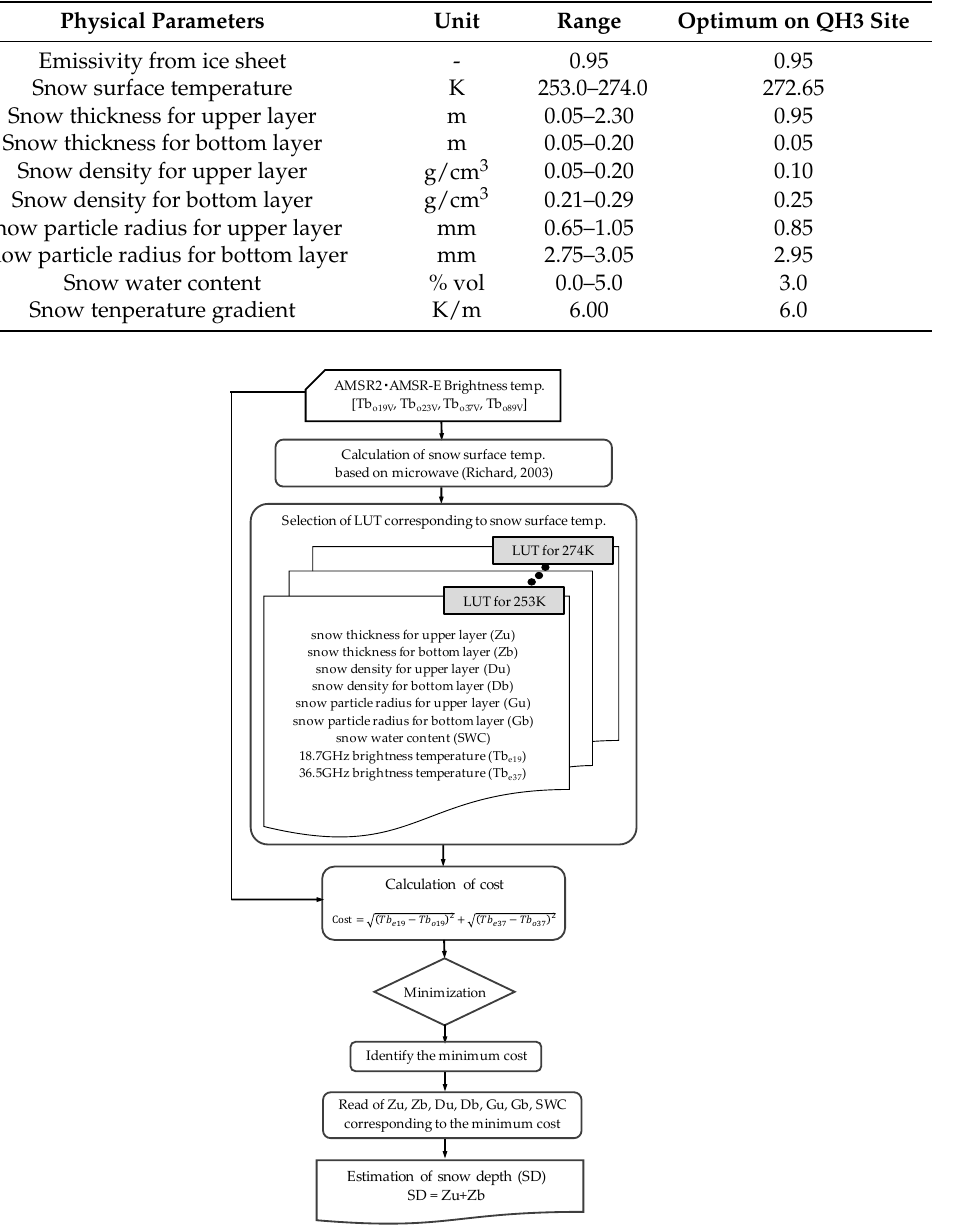
Table 3. Physical parameter range covered by lookup tables based on optimum physical parameters at the QH3 site as an indicator.